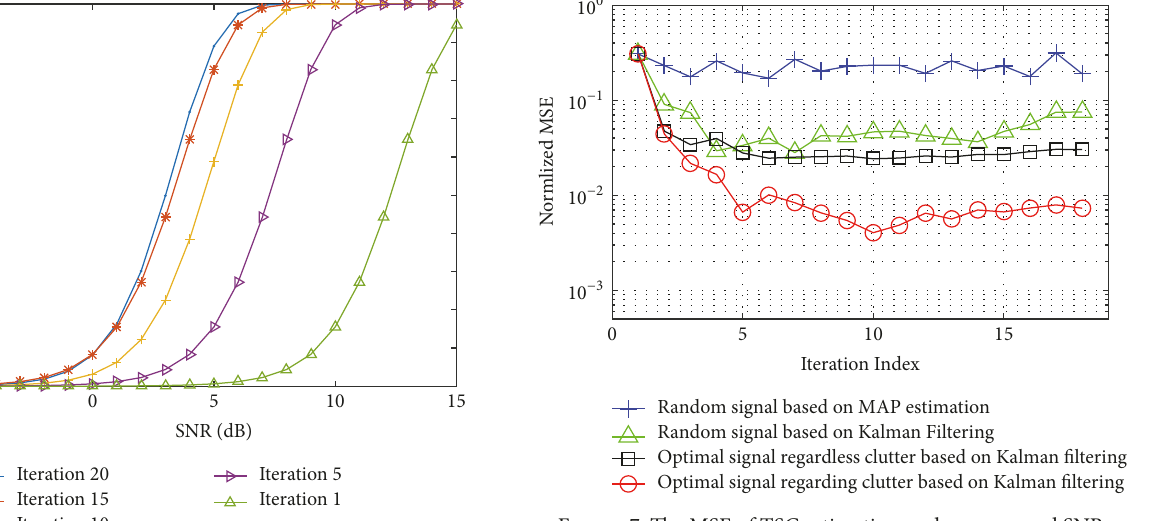
Figure 7: The MSE of TSC estimation under power and SNR.